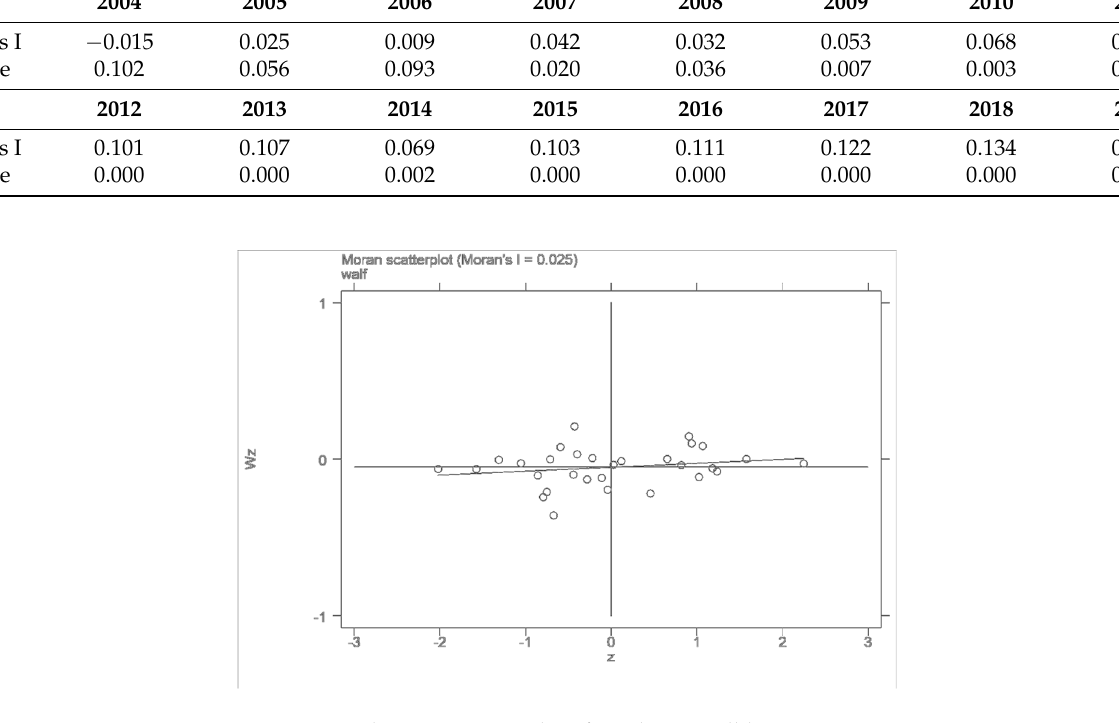
Table 2. Global Moran’s I statistical indicators for the well-being of residents in 30 provinces of